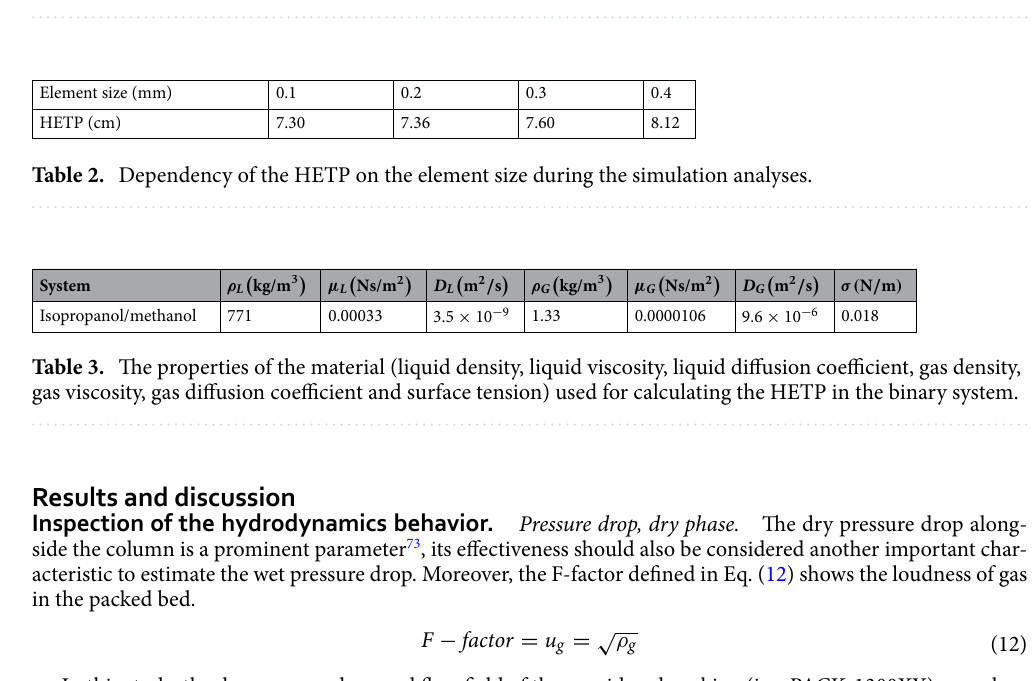
Table 1. Key structural features of the PACK-1300XY during the simulation analyses.